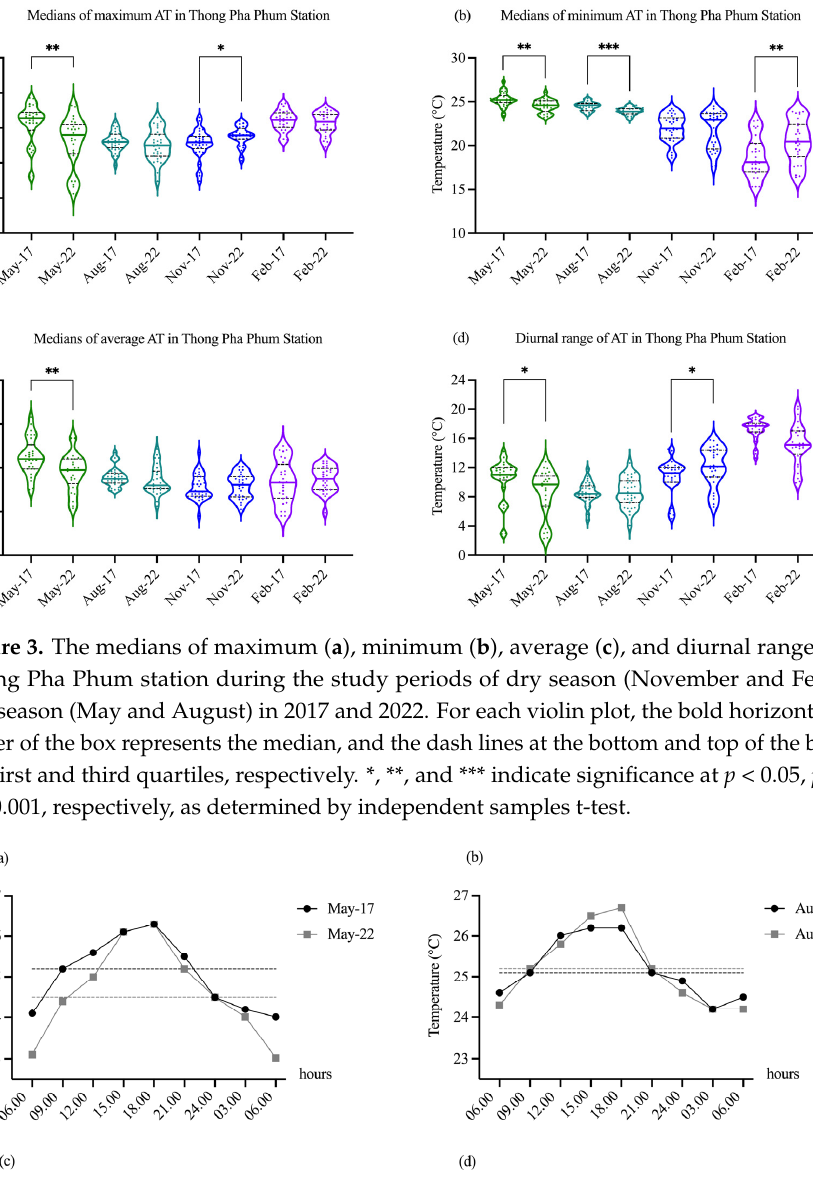
Figure 5. Relationship between daily air temperature (AT) and surface layer water temperature (WT) at Pakkok River during wet and dry season of 2022. The AT and WT water temperature in Pakkok River was monitored at 15th and 28th of each observed month (May, August, November, and February) during 2022 (n = 72). 3.2. CTmax of the Fish in Wet Season and Dry Season CTmax values of fish in paired replicate tanks did not differ significantly during each month ( p ≥ 0.05) and were combined for each of the four species. Body weight of individ- uals in paired replicate tanks also did not differ significantly for each of the four species ( p ≥ 0.05), and were also combined. CTmax was lowest in May with median ± SD for D. regina , C. gachua , R. caudimaculata , and M. chilopterus of 35.0 ± 0.3, 36.0 ± 0.2, 37.1 ± 0.5, and 37.0 ± 0.5 °C, respectively, in 2017, and 35.3 ± 0.3, 36.2 ± 0.5, 37.4 ± 0.4, and 37.5 ± 0.7 °C,